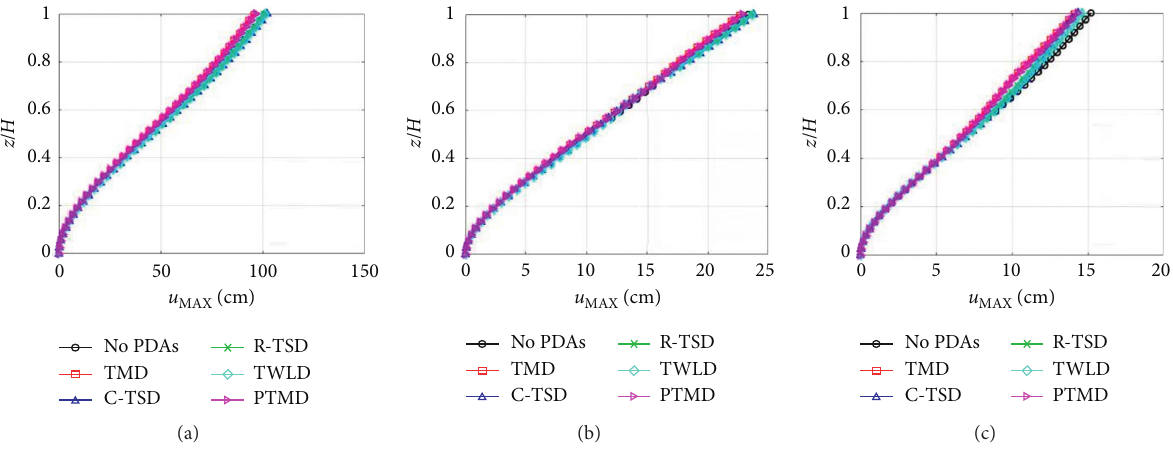
Figure 12: Seismic peak displacements of the building: yz plane. (a) CDAF. (b) SXVI. (c) CUMV.